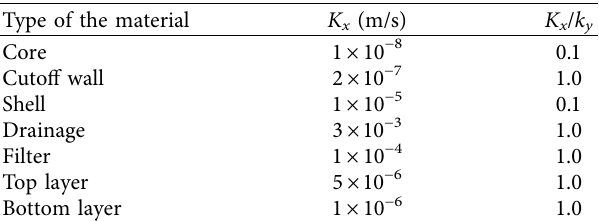
Table 2: The permeability values of SattarKhan Dam materials. Type of the